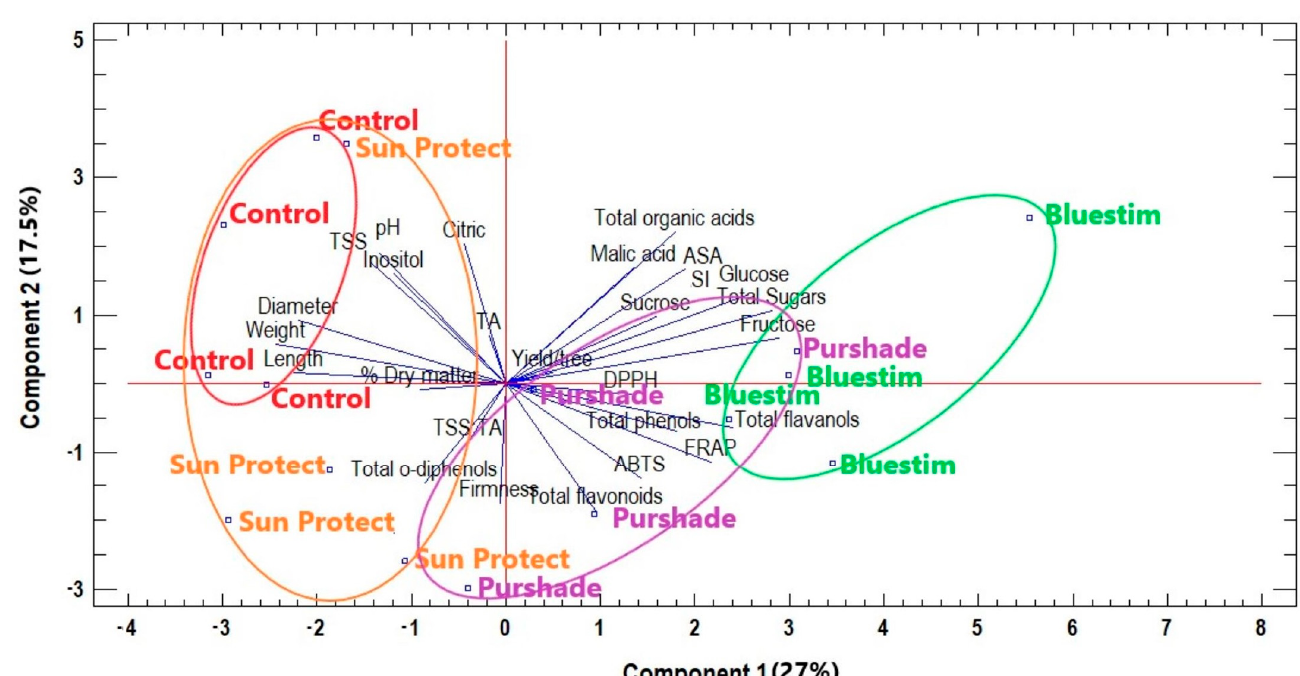
Figure 4. Biplot of the principal components analysis of data collected at harvest. Abbreviations: ABTS, 2,2-azino-bis (3-ethylbenzothiazoline-6-sulfonic acid); ASA, ascorbic acid; DPPH, 2,2-diphenyl-1-picrylhydrazyl; FRAP, Ferric Reducing Antioxidant Power; SI, sweetness index; TA, titratable acidity; TSS, total soluble solids; TSS:TA, ratio of total soluble solids:titratable acidity.